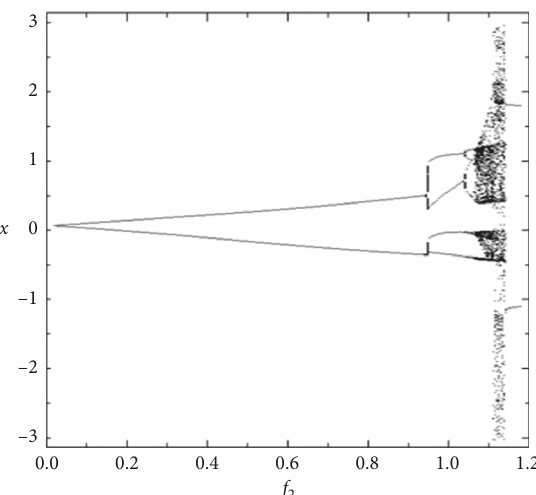
Figure 4: Bifurcation diagram with different values of parameter f